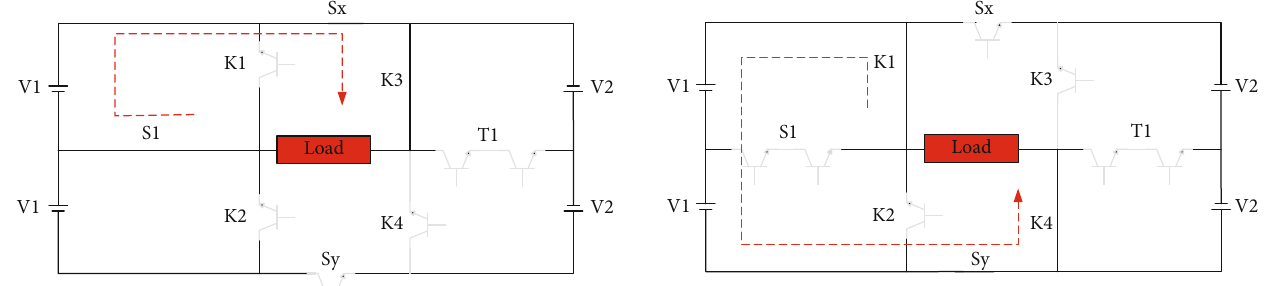
Figure 8: Current fl ow for the 6 th switching